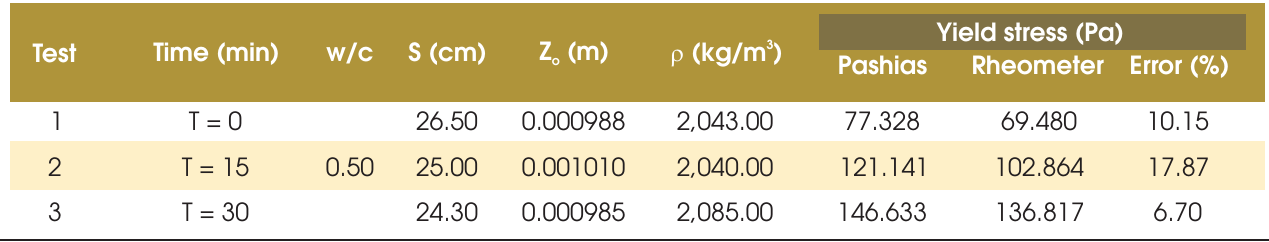
Table 15 – Comparison of the yield stress calculated by the method of Pashias and by classical rheometry with their respective errors, for mortars produced with CPV ARI, w/c = 0.50 and sieved